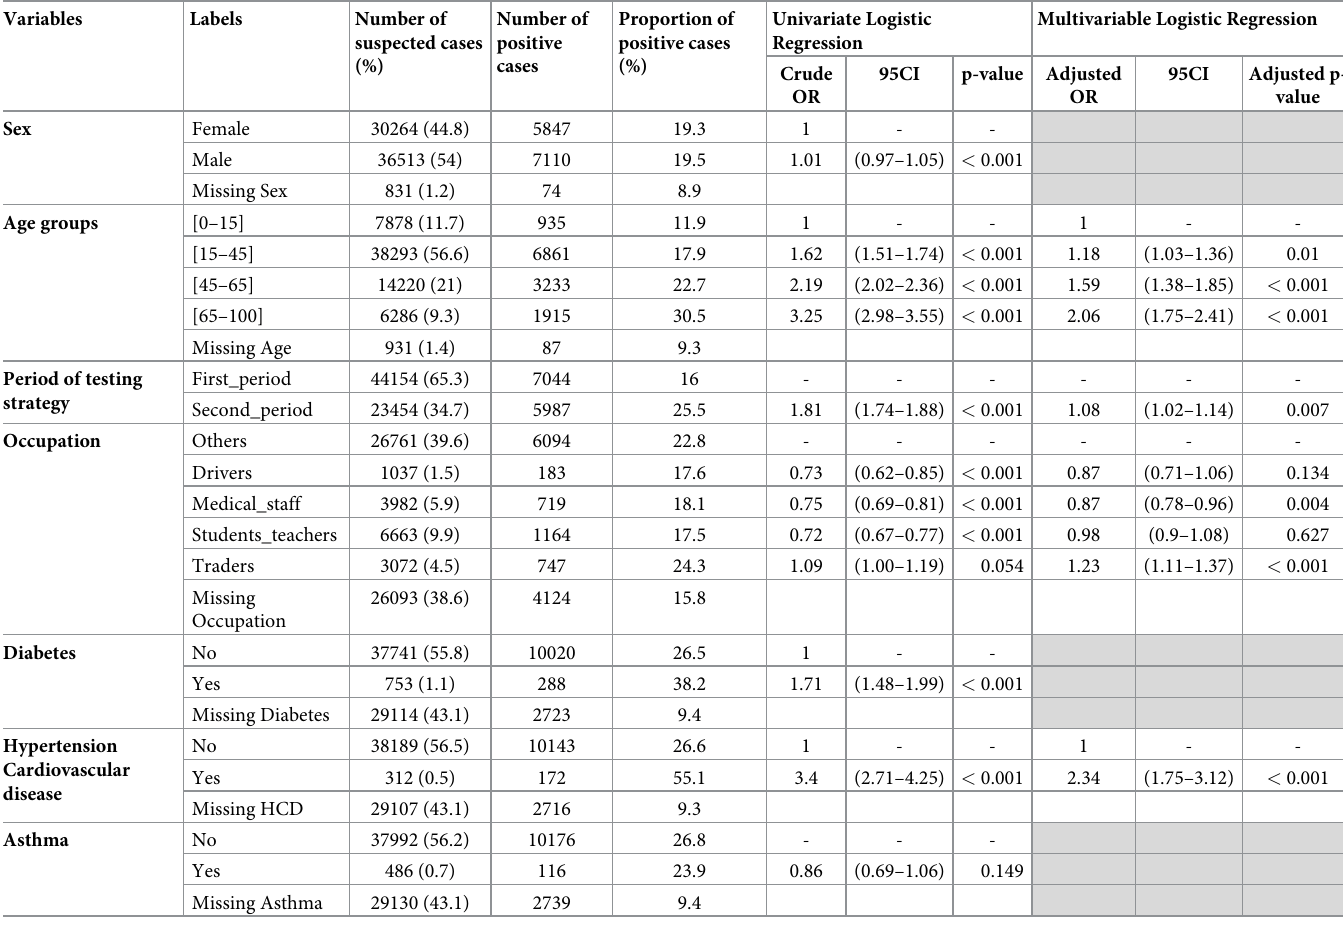
Table 1. Univariate and multivariable factors analysis according to "uninfected/infected" status.